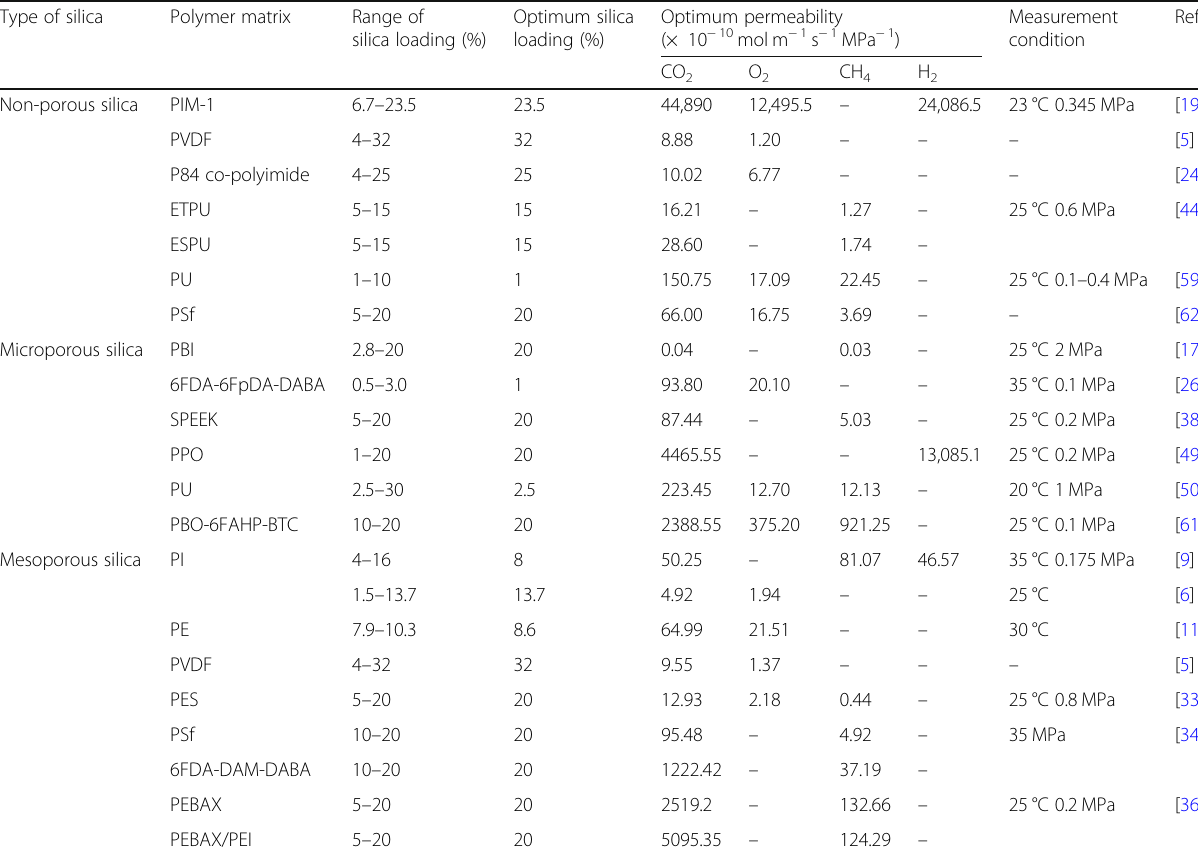
Table 5 Optimum gas permeability of several mixed matrix membranes containing silica particles Type of silica Polymer